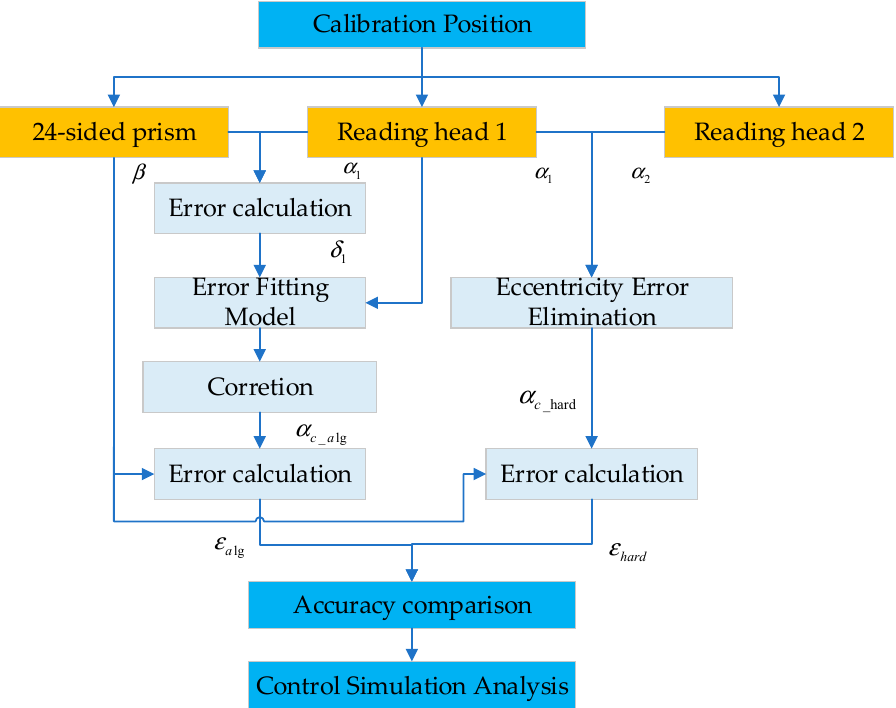
Figure 3. Circular grating error calibration process.